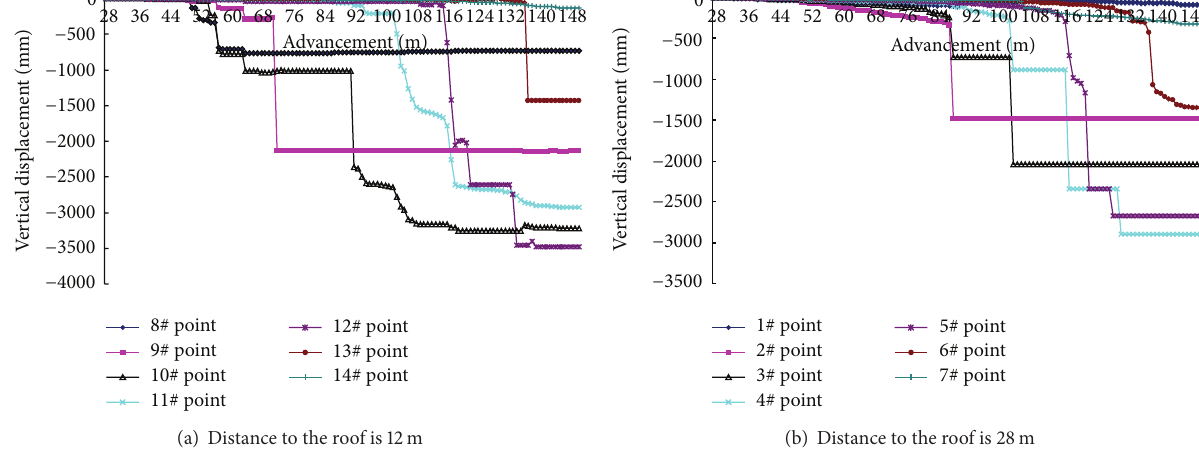
Figure 6: Roof vertical displacement along with advancement.